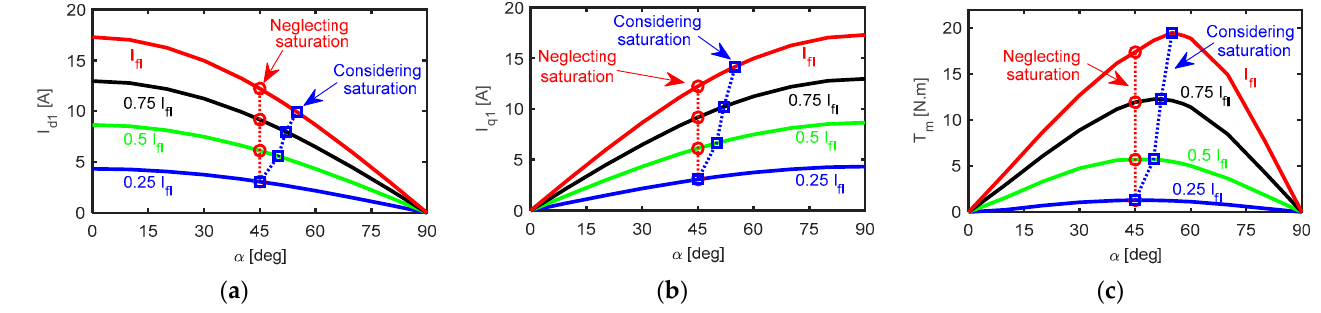
Figure 8. Five-phase combined star-pentagon SynRM; ( a ) fundamental d-axis current, ( b ) fundamental q-axis current, and ( c ) average torque at different currents, at different current angle and at rated speed.